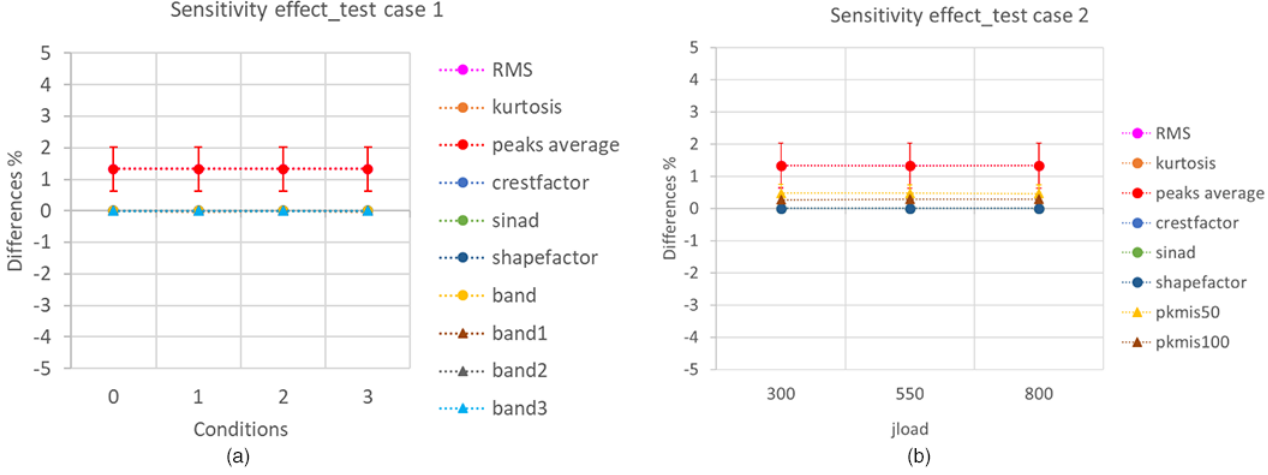
Fig. 4. Effect of the sensitivity on features for CM, in cases 1 (a) and 2